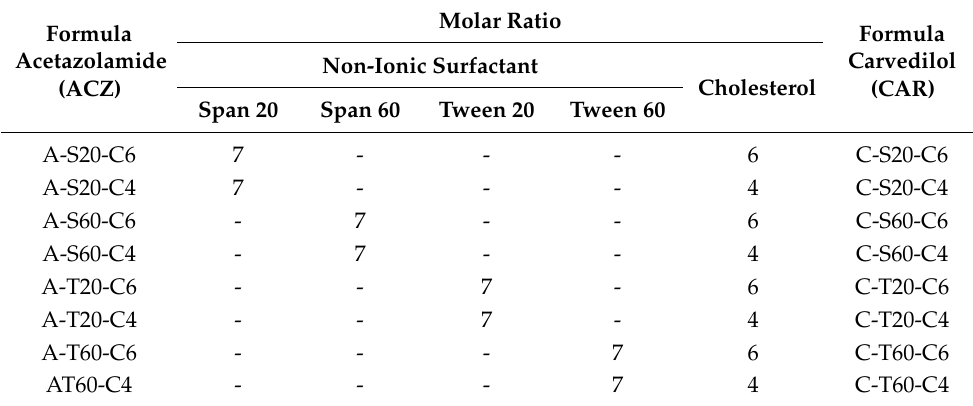
Table 1. Composition of niosomes formulations, n = 3.